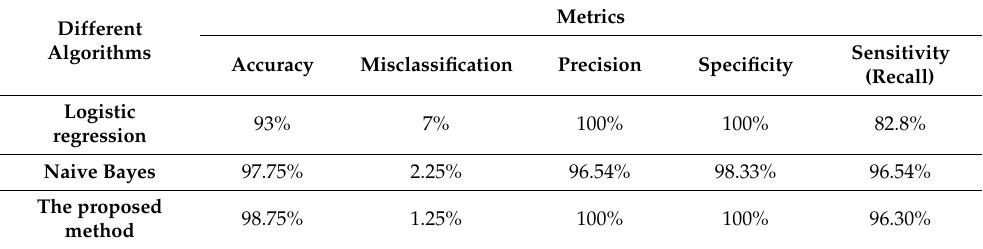
Table 4. Comparison of different metrics measuring the validity of the proposed DC series arc fault detection algorithm with other